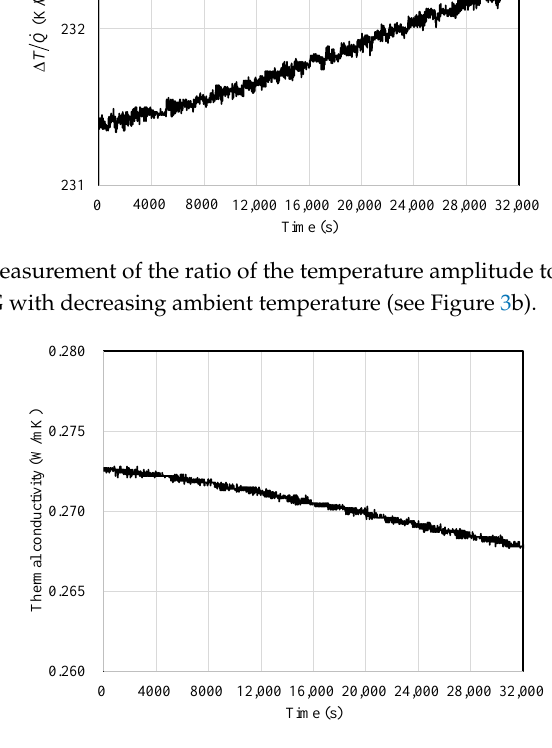
Figure 6. The transient thermal conductivity of EG, calculated from the temperature amplitude at 125 Hz while the ambient temperature decreases as shown in Figure 3b.